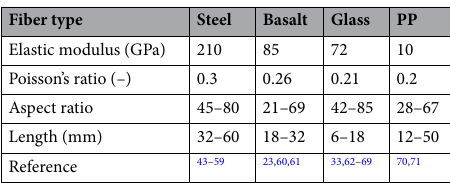
Table 6. Physical and mechanical properties of fibers.